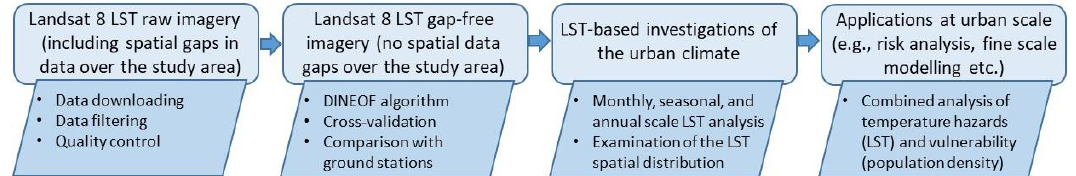
Figure 4. Workflow from raw Landsat 8 LST data to applications based on gap-free LST in an urban area.